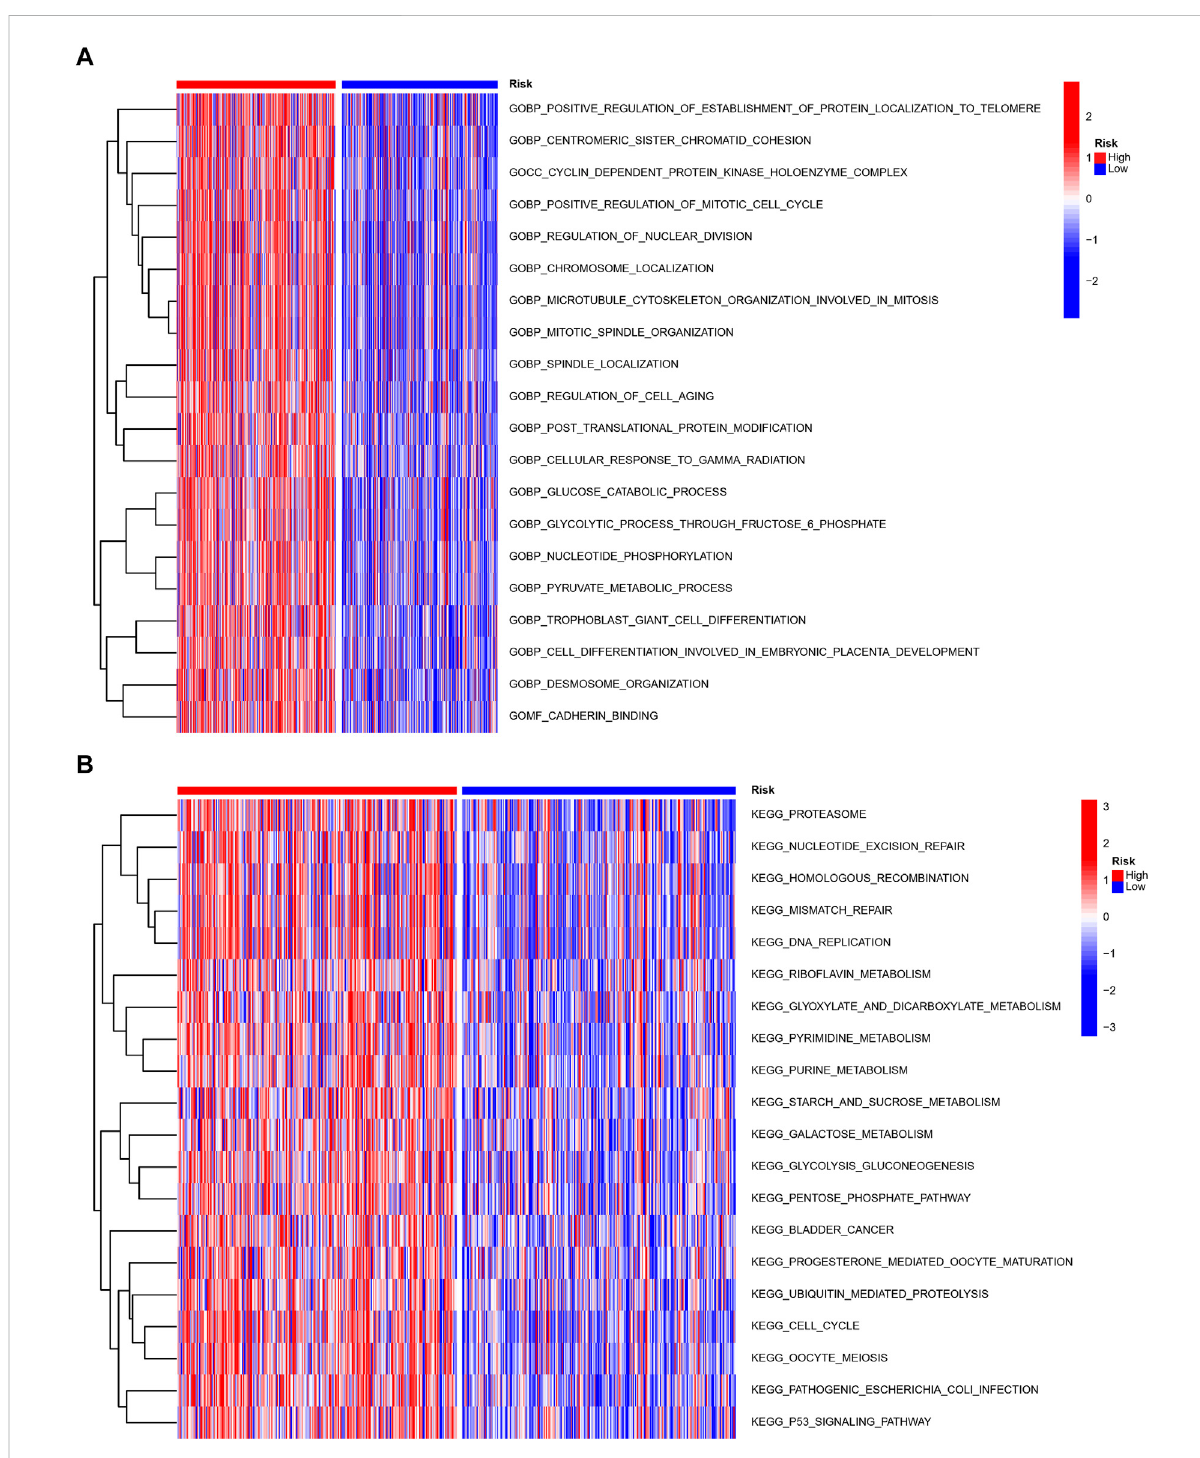
FIGURE 7 Molecular characteristics of patients in the high- and low-risk groups. The GSVA analysis in the high- and low-risk group to enrich GO characteristic gene sets (A) and KEGG gene sets (B)